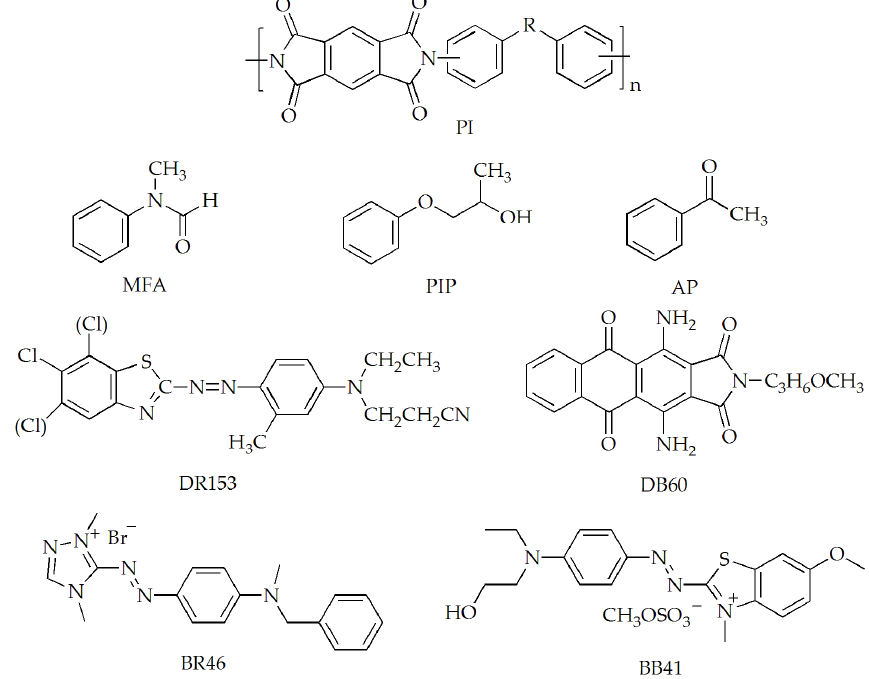
Figure 1. Chemical structures of Polyimide (PI) fibers, dyes and swelling agents.